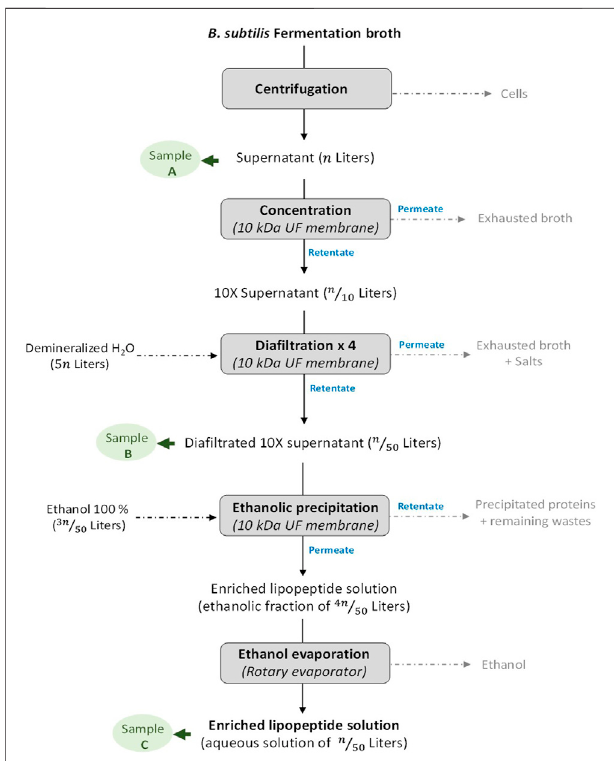
FIGURE 1 | Description of the work fl ow for the production and puri fi cation of lipopeptides from the fermentation of Bacillus subtilis to the enriched lipopeptide solution in an aqueous solution. The different steps where a sample has been taken for spray-drying experiments are highlighted as Sample (A – C)